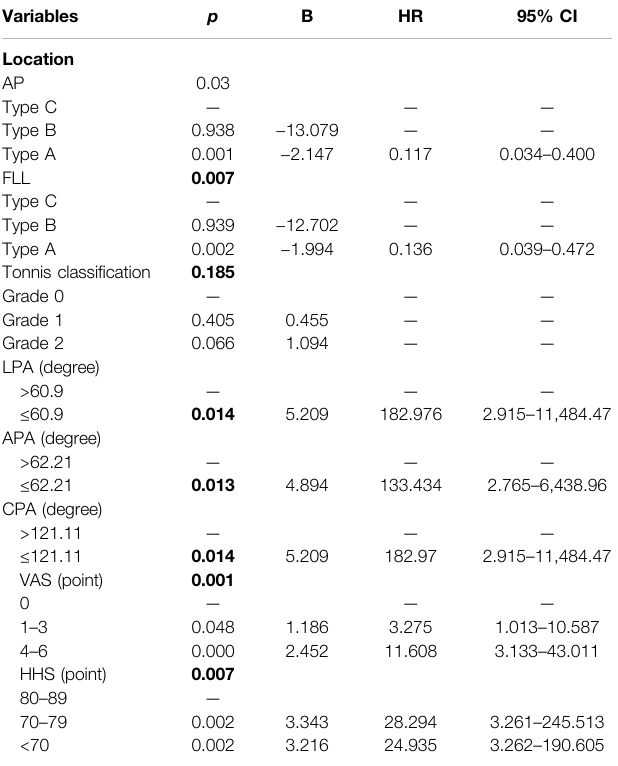
TABLE 3 | Univariate Cox regression analysis of the risk factors associated with collapse. Variables